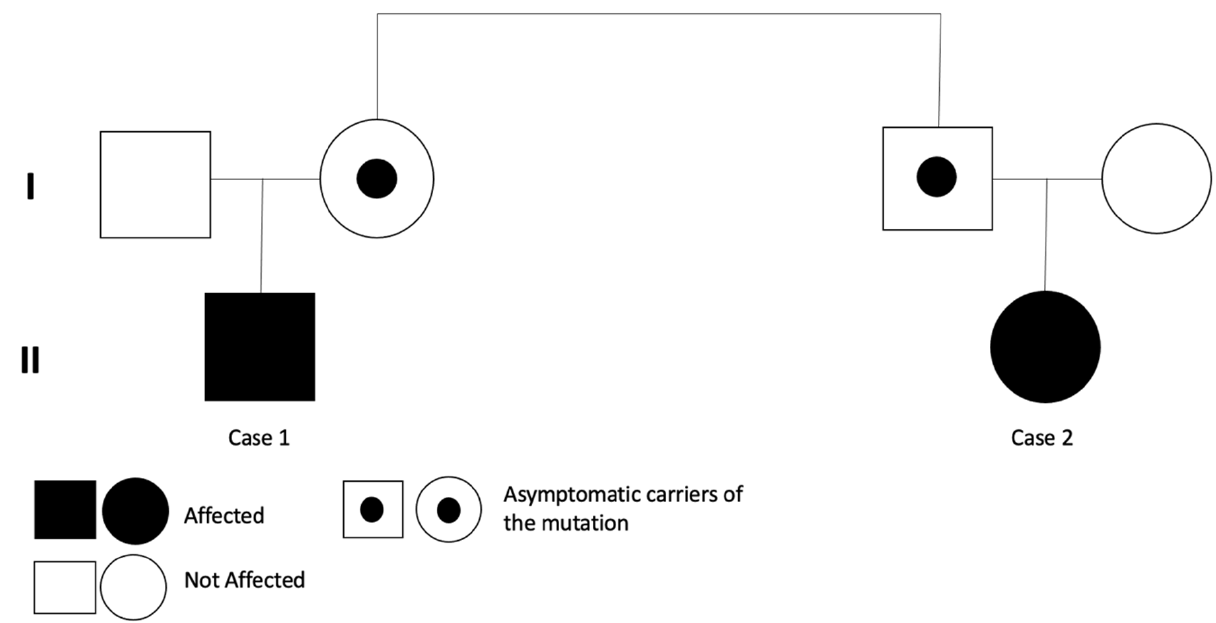
Figure 3. The pedigree of the family in this